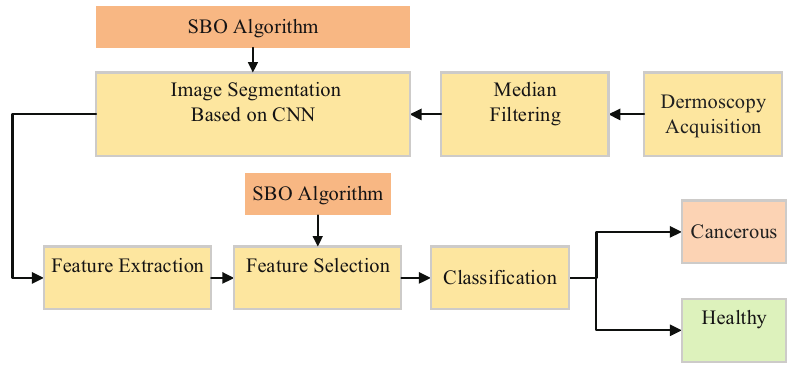
Figure 1: The fl owchart of the proposed skin cancer diagnosis